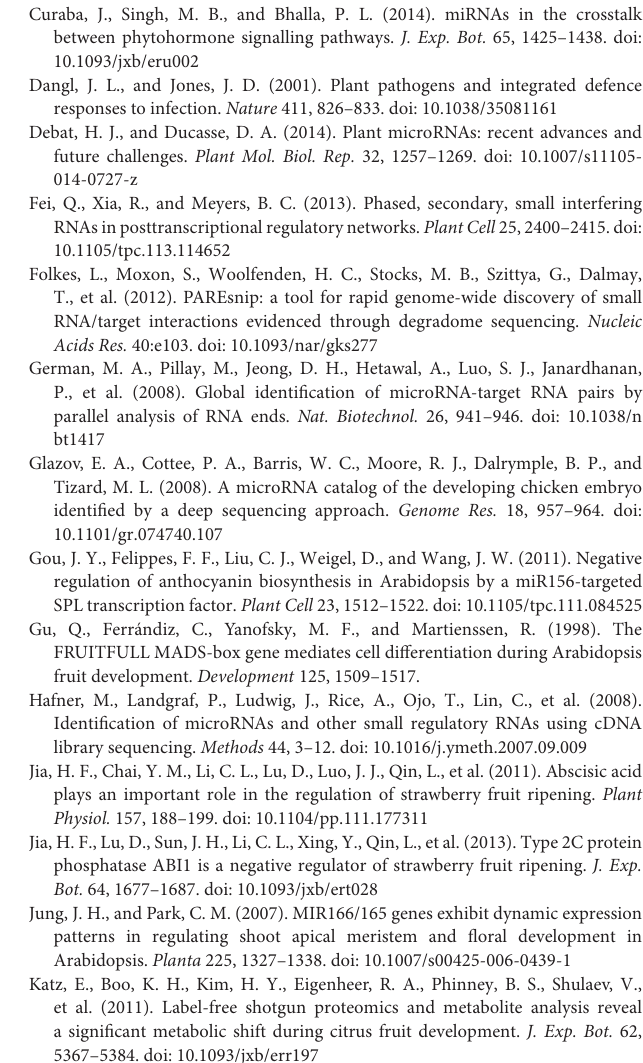
Figure S4 | Predicted secondary structures of the novel miRNAs. The mature miRNA sequences are highlighted in blue and the miRNA ∗ sequences are highlighted in red. Figure S5 | T-plots of the miRNA targets. Figure S6 | Distribution of the identified miRNAs and their targets in the Citrus sinensis genome. The arrows indicate target genes. Table S1 | Summary of the known miRNAs in WT and MT. Table S2 | Summary of the novel miRNAs in WT and MT. Table S3 | Targets of the miRNAs identified using degradome sequencing. Table S4 | Annotations of all target genes. Table S5 | Gene ontology classification of miRNA targets. Table S6 | PHAS genes and phasiRNAs identified in MT and WT. Table S7 | Identified PHAS genes in citrus